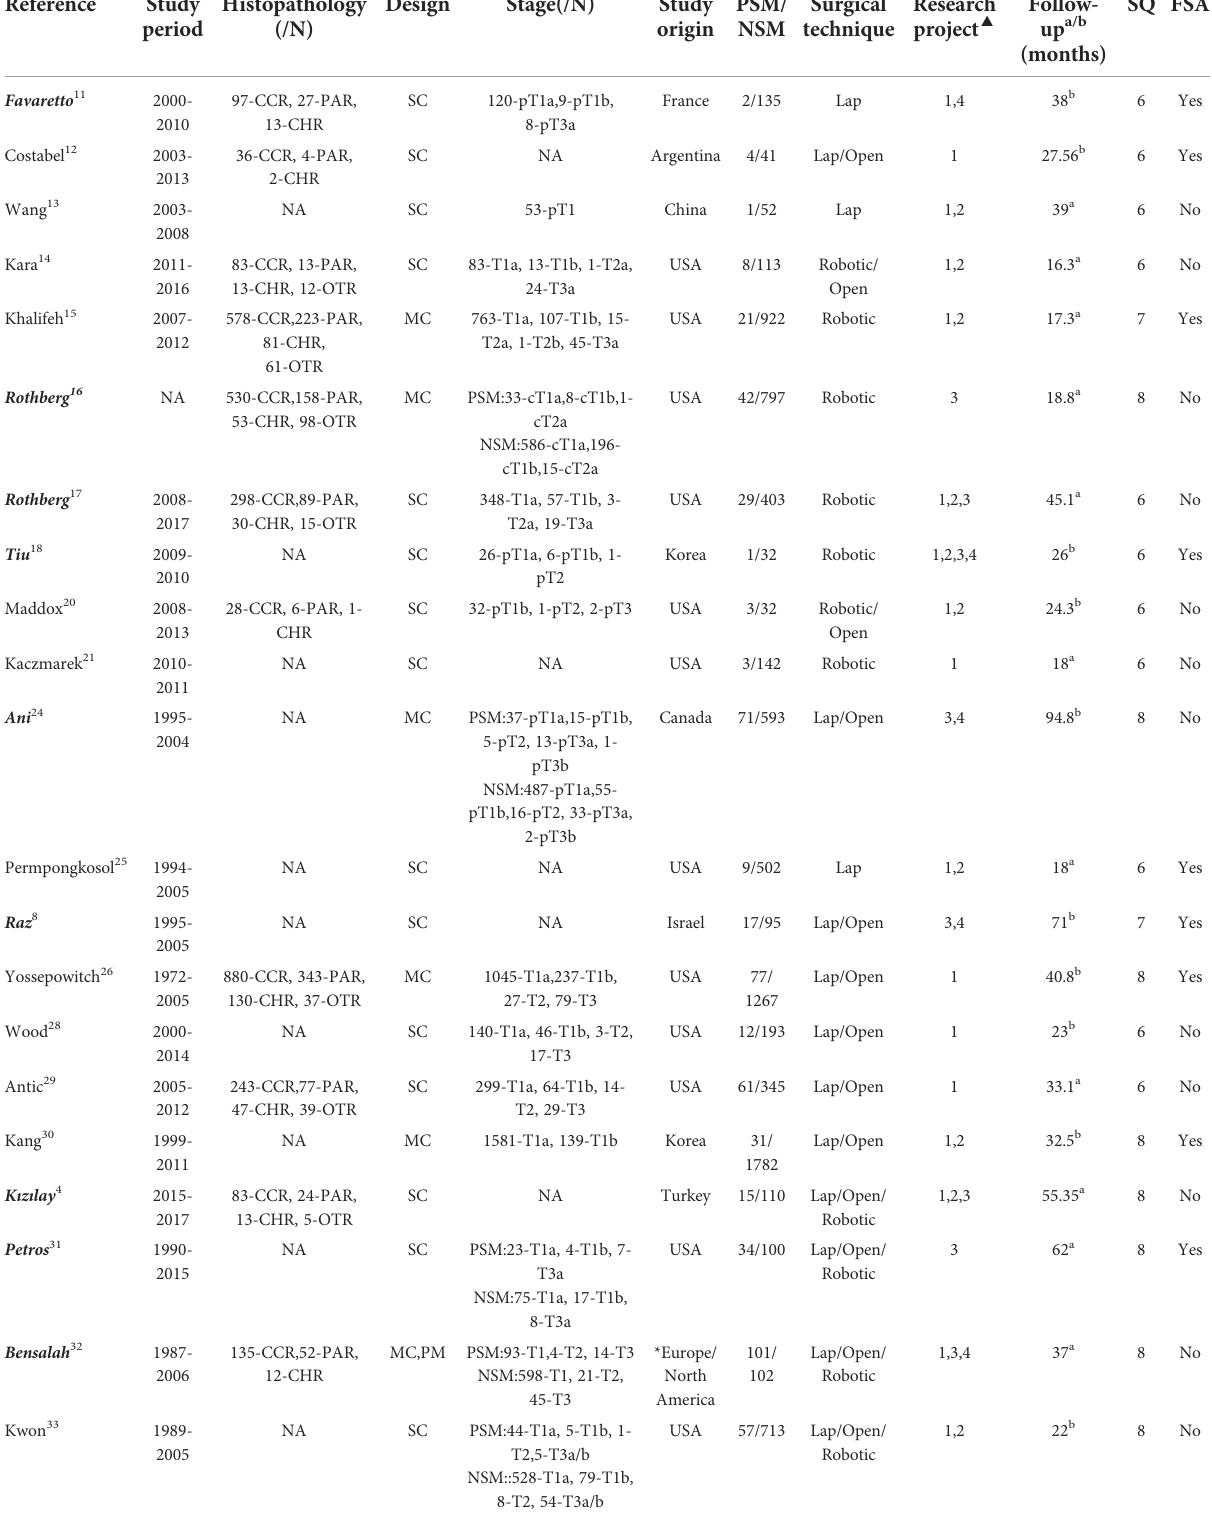
TABLE 1 Characteristics and quality of included